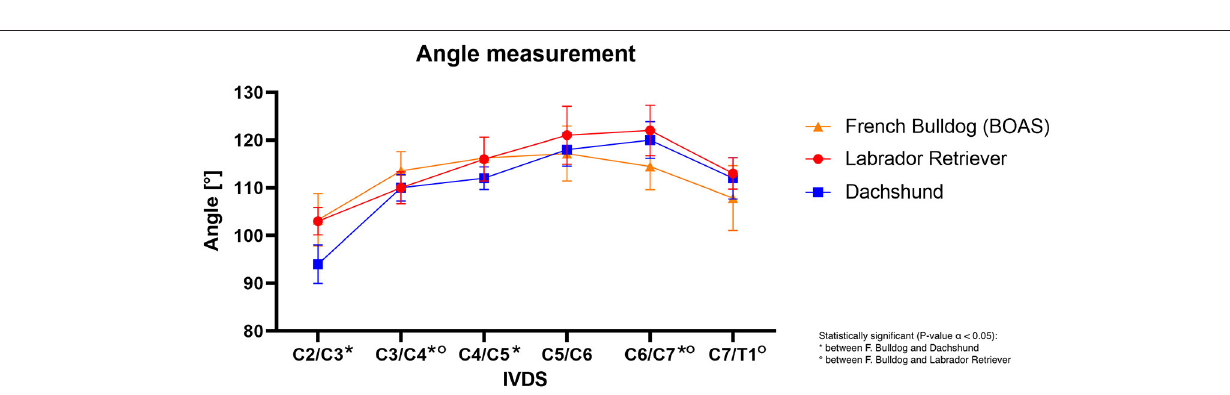
more prominent than the ventral paraspinal musculature